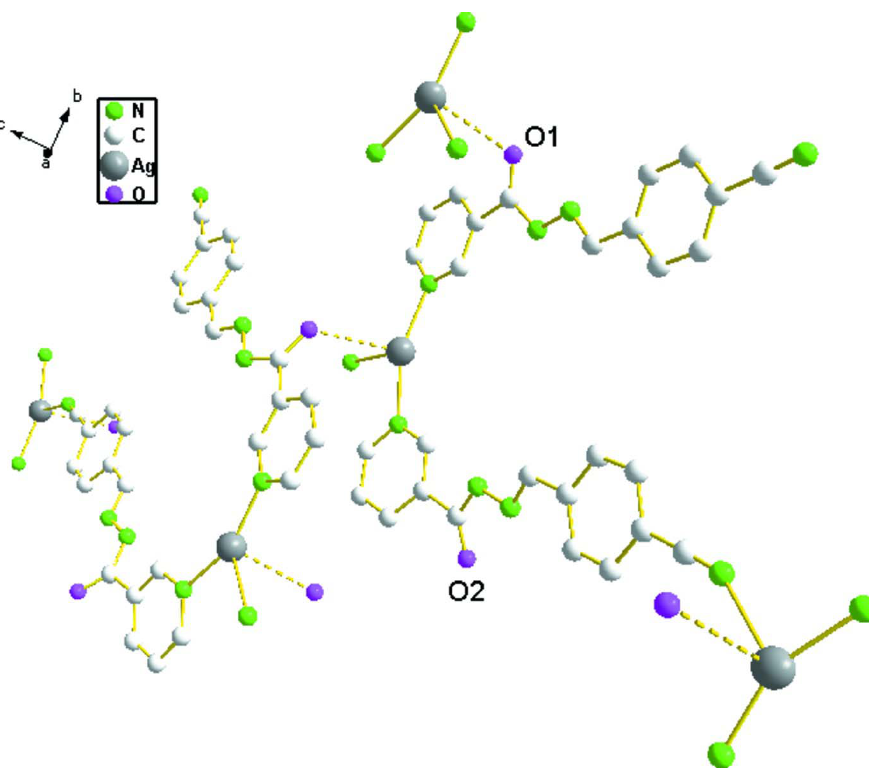
A diagram showing the intermolecular Ag···O interactions indicated by dashed lines. All counteranions and H atoms have been omitted for